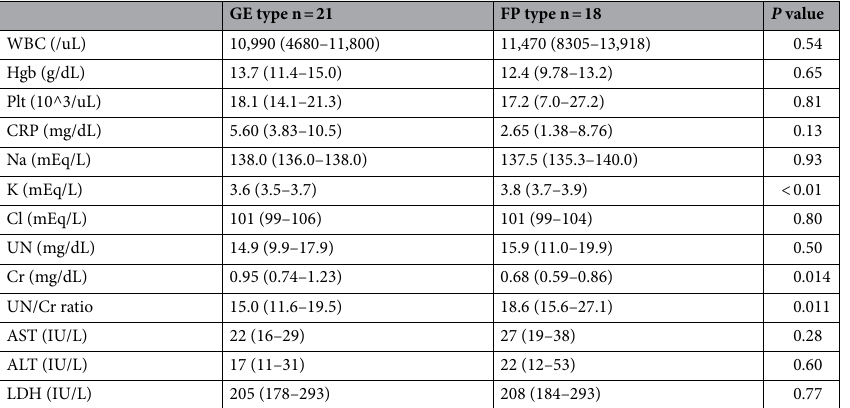
Table 2. Comparison of laboratory data on admission between GE type and FP type Campylobacter bacteremia. The data were analyzed by the Mann–Whitney U test. Median and interquartile range are demonstrated. ALT alanine amino transferase, AST aspartate aminotransferase, Cl chloride, Cr creatinine, CRP C-reactive protein, Hgb hemoglobin, K potassium, LDH lactate dehydrogenase, Plt platelets, Na sodium, UN urea nitrogen, WBC white blood cells, GE gastroenteritis, FP fever